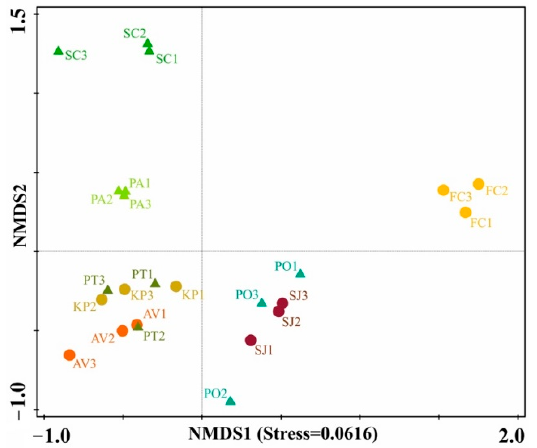
Figure 6. Nonmetric multidimensional scaling (NMDS) of rhizosphere bacterial community in different stands. (AV, A. vulgaris ; SJ, S. japonica ; KP, K. paniculata ; FC, F. chinensis ; PO, P. orientalis ; PT, P. tabuliformis ; PA, P. asperata ; SC, S. chinensis .)